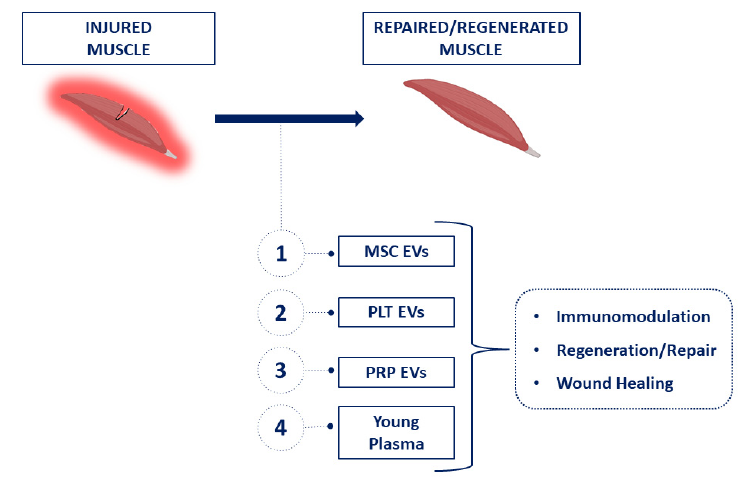
Figure 6. Scheme of EV interaction in the muscle repair process.